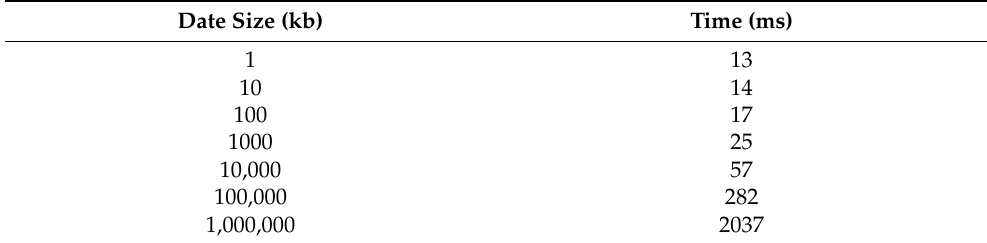
Table 8. Hash Performance.